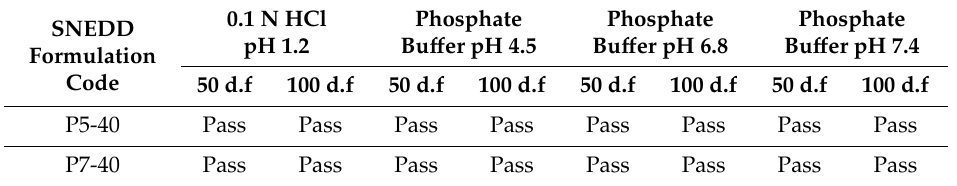
Table 3. Effect of dilution and pH on the stability of optimized DFX loaded SNEDD formulations.